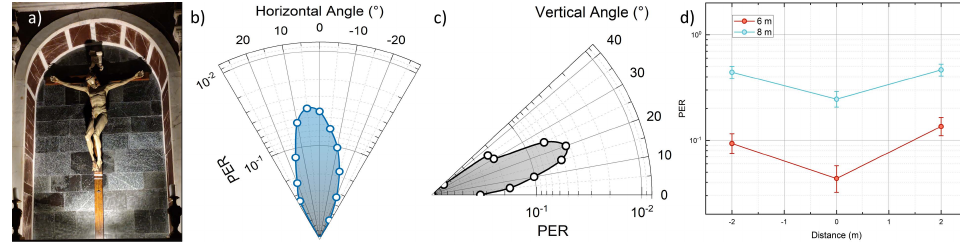
Figure 7. Experimental determination of effective RX FoV in terms of PER performances. Data report measured PER values relative to Brunelleschi’s Crucifix (panel ( a )) as a function of the horizontal ( b ) an vertical ( c ) angular orientation of RX axis, at 6 m distance. Panel ( d ) reports the measured PER for side shifts of ± 2 m, at 6 m (red) and 8 m (cyan) distance from